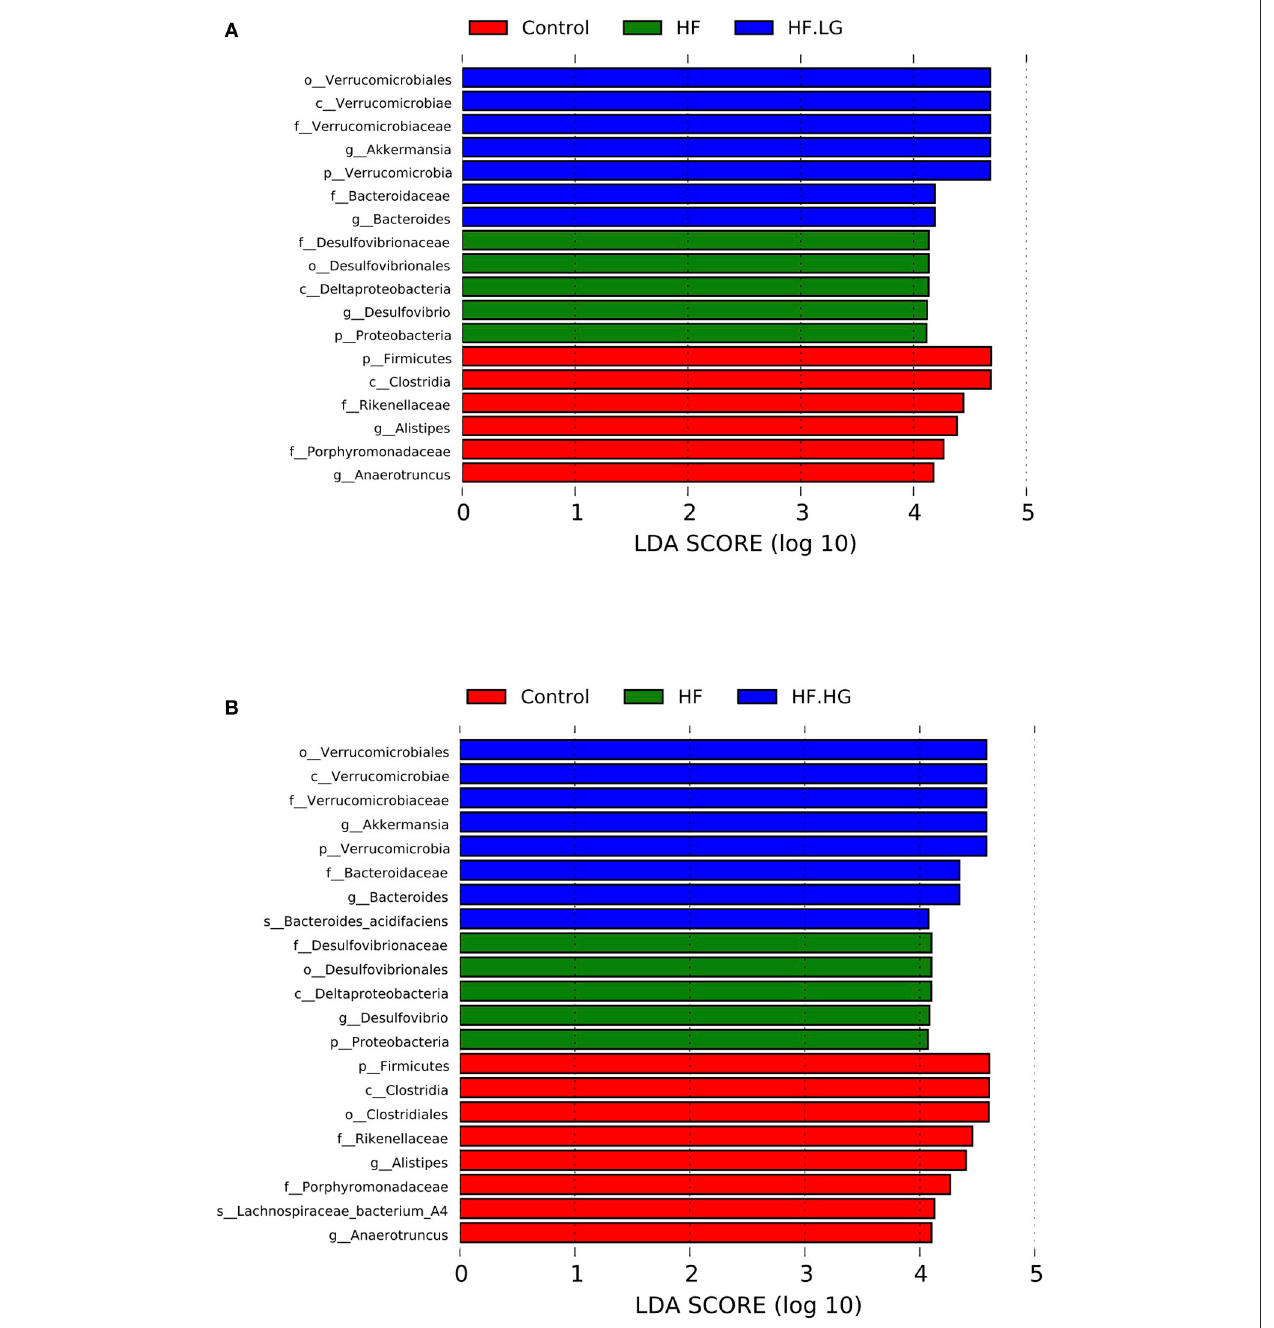
FIGURE 7 | The LEfSe analysis of the different gut microbiota from the phylum level down to the species level ( n = 6–8/group). (A) Differently enriched bacteria among the HF-HF.LG-Control group; and (B) Differently enriched bacteria among the HF-HF.HG-Control group. HF, high-fat diet without genistein; HF. LG, high-fat diet with low-dose genistein; HF. HG, high-fat diet with high-dose genistein; Control, normal control